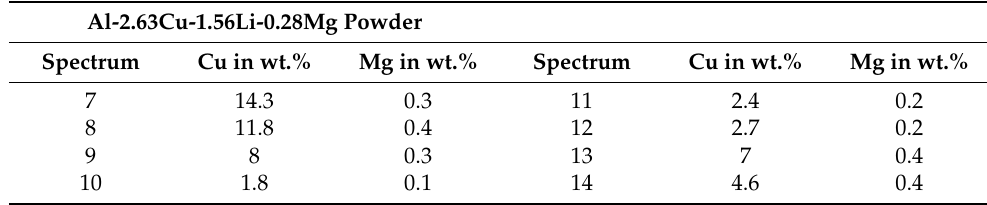
Figure 13. EDX analysis of Al-2.63Cu-1.56Li-0.28Mg powder. Table 4. EDX results of Al ‐ 2.63Cu ‐ 1.56Li ‐ 0.28Mg powder.